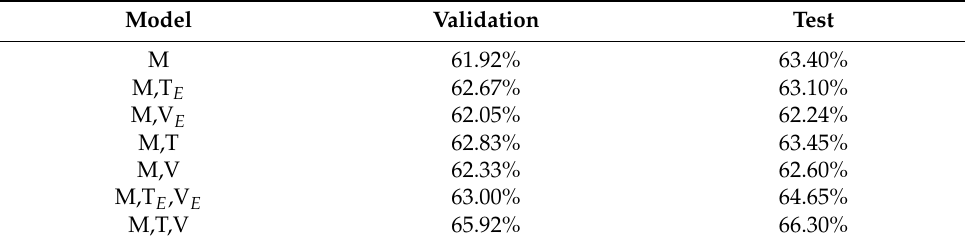
Table 2. The prediction accuracy of the multi-task learning models with the addition of different unimodal auxiliary